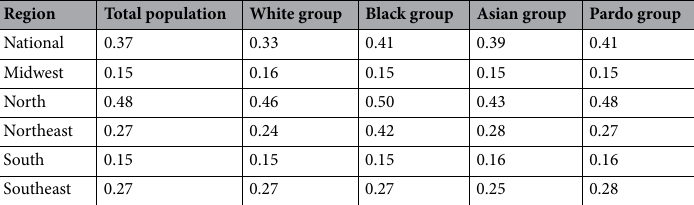
Table 2. Gini coefficients for the total population and racial group for weather penalties.